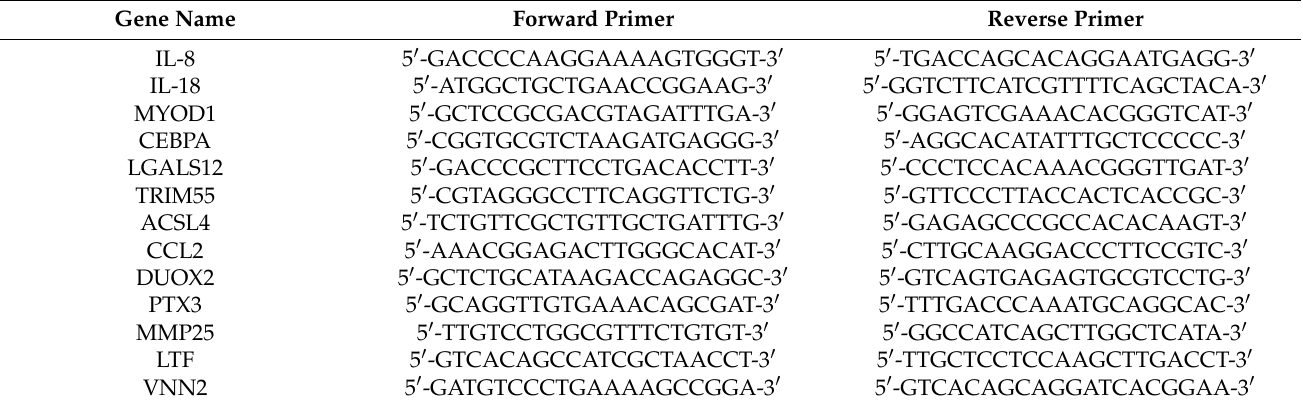
Table 1. The nucleotide sequence (5 (cid:48) –3 (cid:48) ) of the primers used for a real-time quantitative poly- merase chain reaction. Interleukin (IL), C-C Motif Chemokine Ligand 2 (CCL2), CCAAT Enhancer Binding Protein Alpha (CEBPA), Lactotransferrin (LTF), Galectin 12 (LGALS12), Dual Oxidase 2 (DUOX2), Vanin 2 (VNN2), Myoblast Determination Protein 1 (MYOD1), Tripartite Motif Contain- ing 55 (TRIM55), Pentraxin 3 (PTX3), Matrix metalloproteinase 25